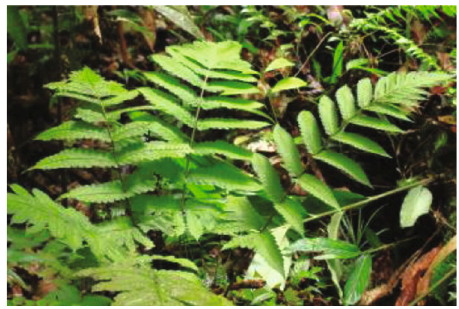
Figure 6: Pleocnemia irregularis (C. Presl) Holttum.